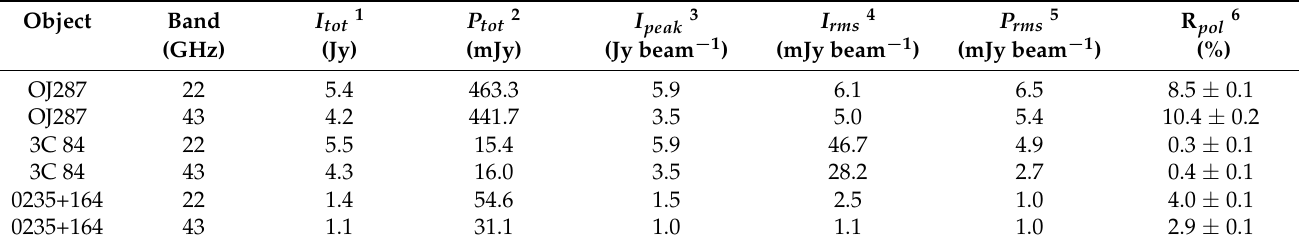
Table 4. Summary of 22 and 43 GHz Image